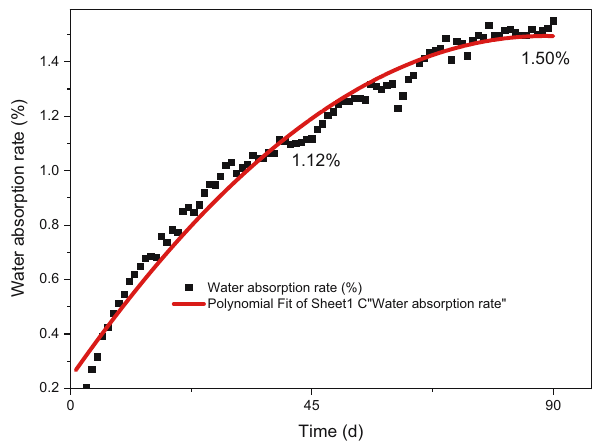
Figure 13: Water absorption